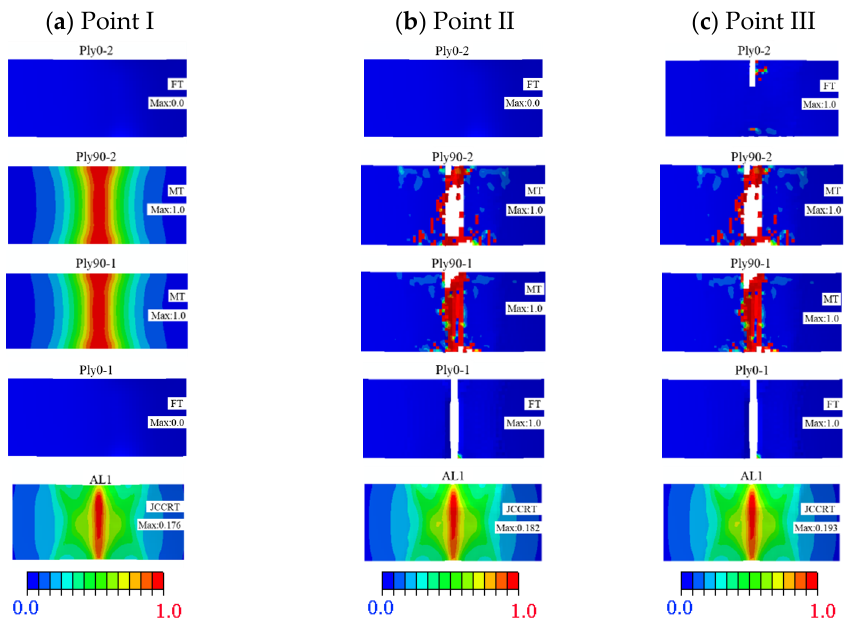
Figure 19. Damage program of the carbon fibre layer and the aluminium layer below the neutral layer at different fracture points: ( a ) Point I; ( b ) Point II; ( c ) Point III.